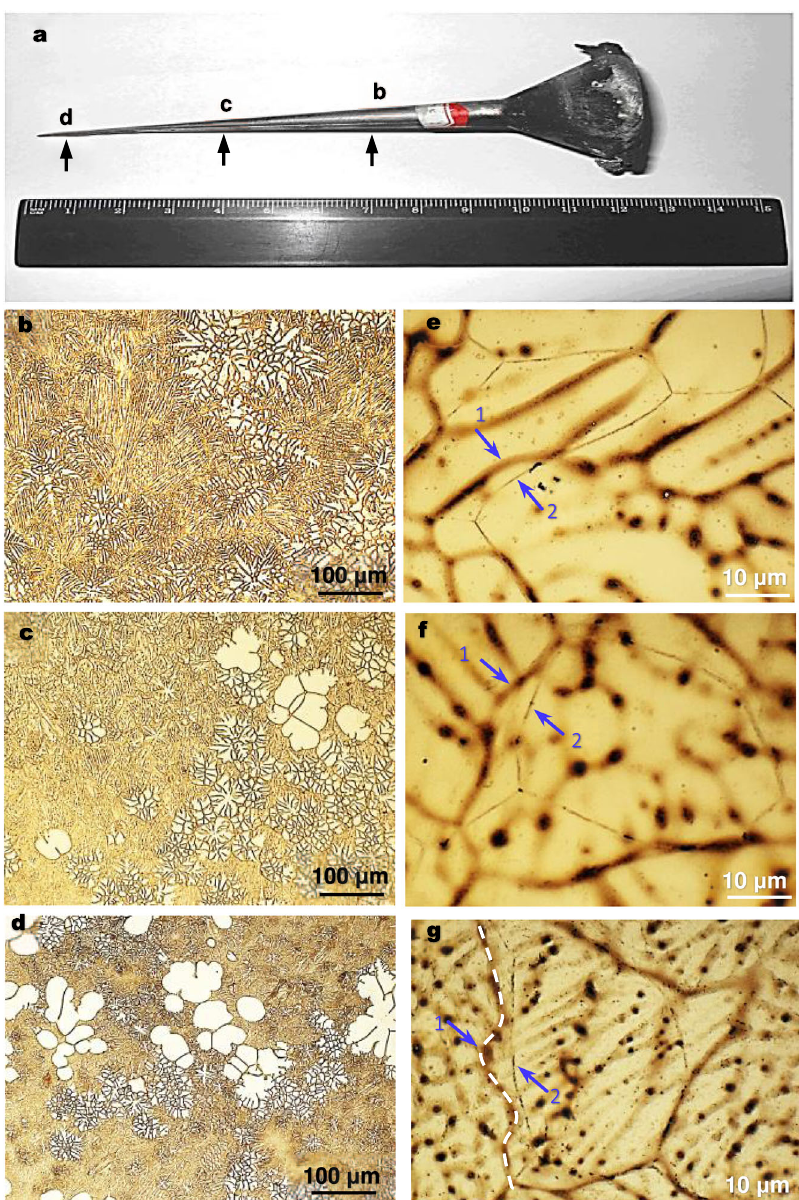
Fig. 4| SGBMatdifferentcoolingrates.a Anas-castcone-shaped Mg-0.63at.%Sn (3 wt.%Sn) specimen. b – d Grain structures at each speci fi ed position in the cone- shaped specimen ( a ). e – g Closer views of the SGBM in the grain structures at each speci fi ed position. Arrow 1 in each micrograph points to the initial SGB position